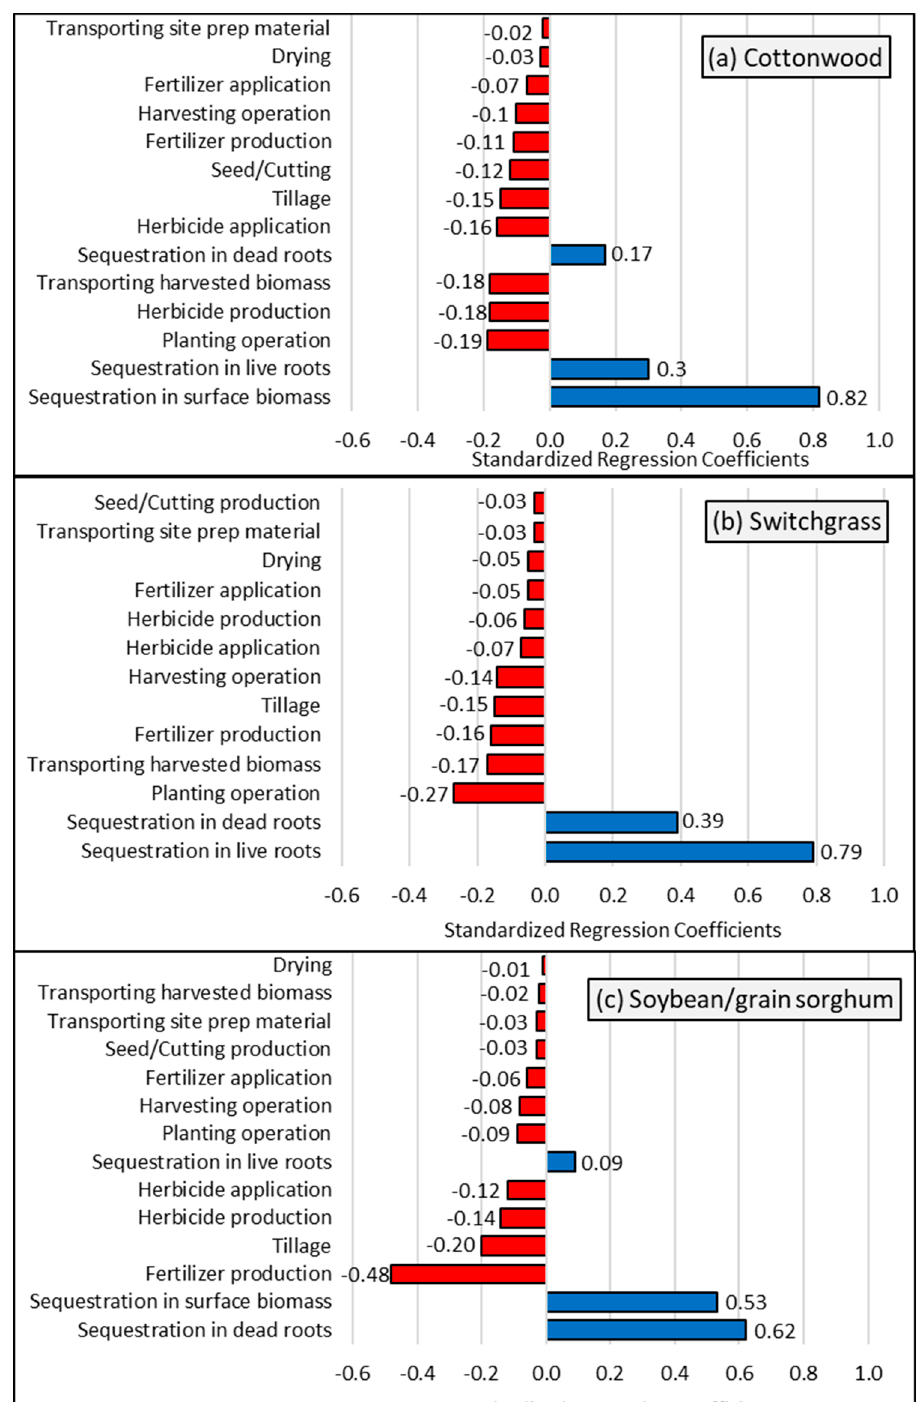
Figure 5. Standardized regression coefficients for net ratio of carbon sequestration to emission.